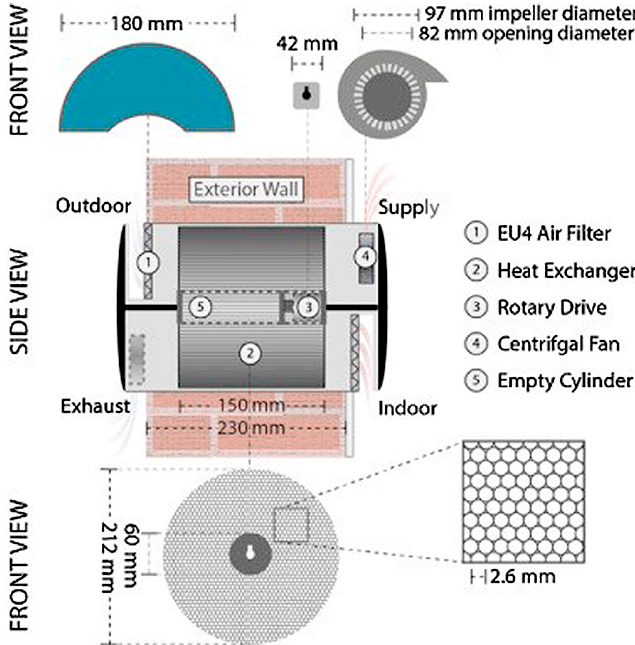
Figure 12. Schematic representation of the plastic rotary wheel system [45].